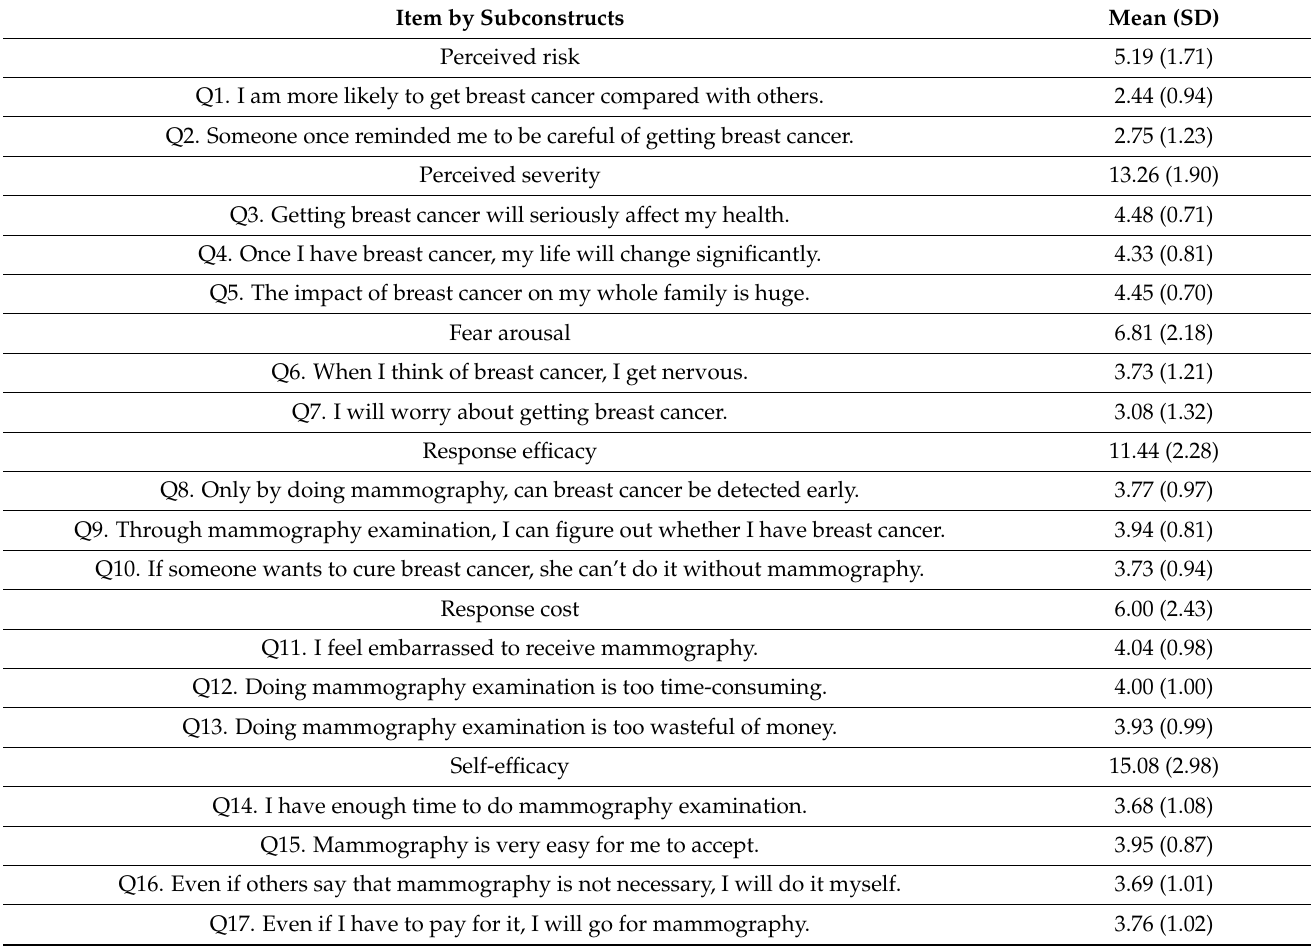
Table A1. Items of the 17-Item Breast Cancer PMT